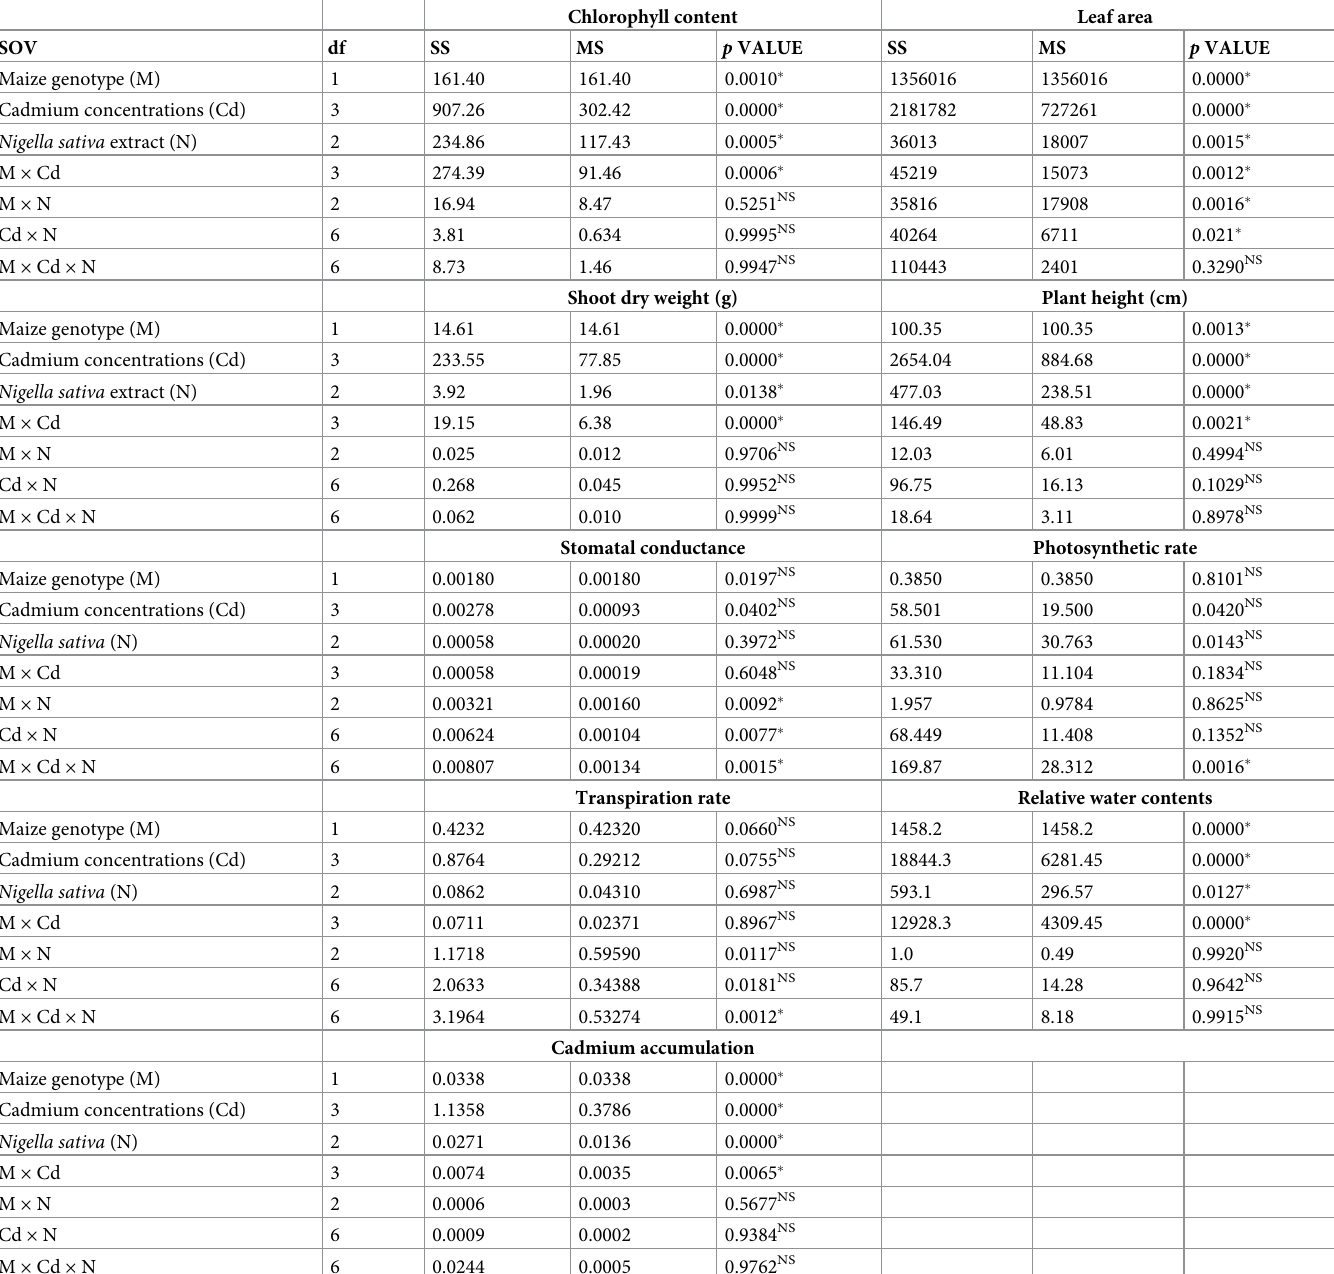
Table 2. Analysis of variance of different growth and biochemical traits of different maize genotypes (synthetic vs hybrid) treated with various black cumin seed extract concentrations (0, 10 and 20%) under different Cd concentrations (0, 4, 8 and 12 mg kg -1 ). Chlorophyll content